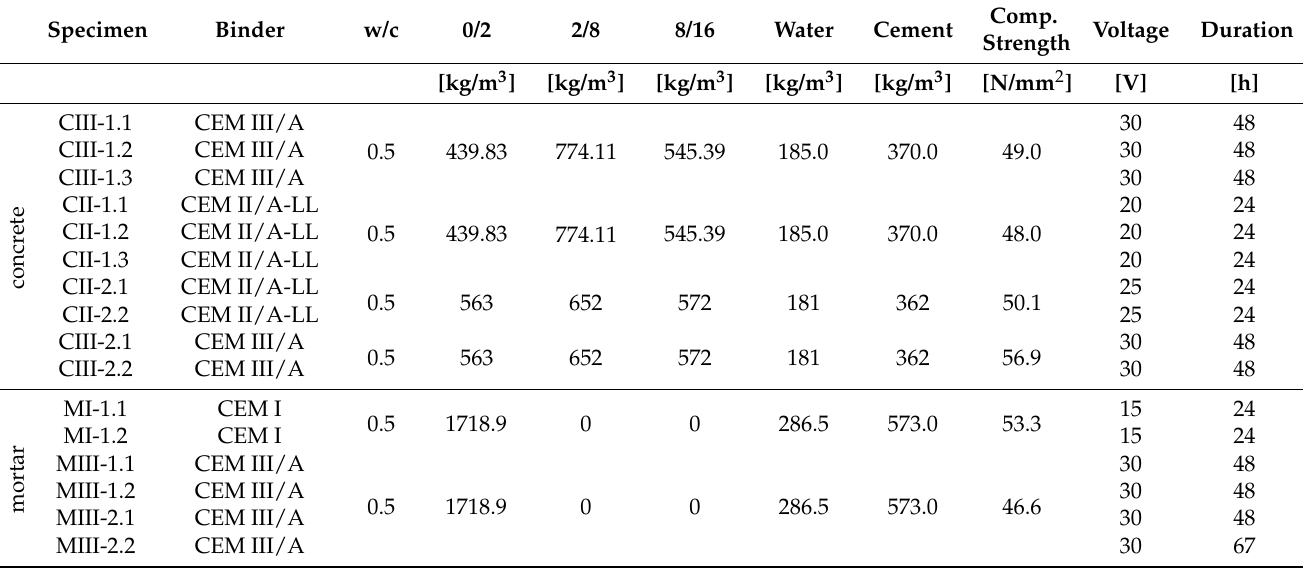
Table 1. Concrete mix design, compressive strength at the age of 28 days as well as voltage and duration of RCM test.